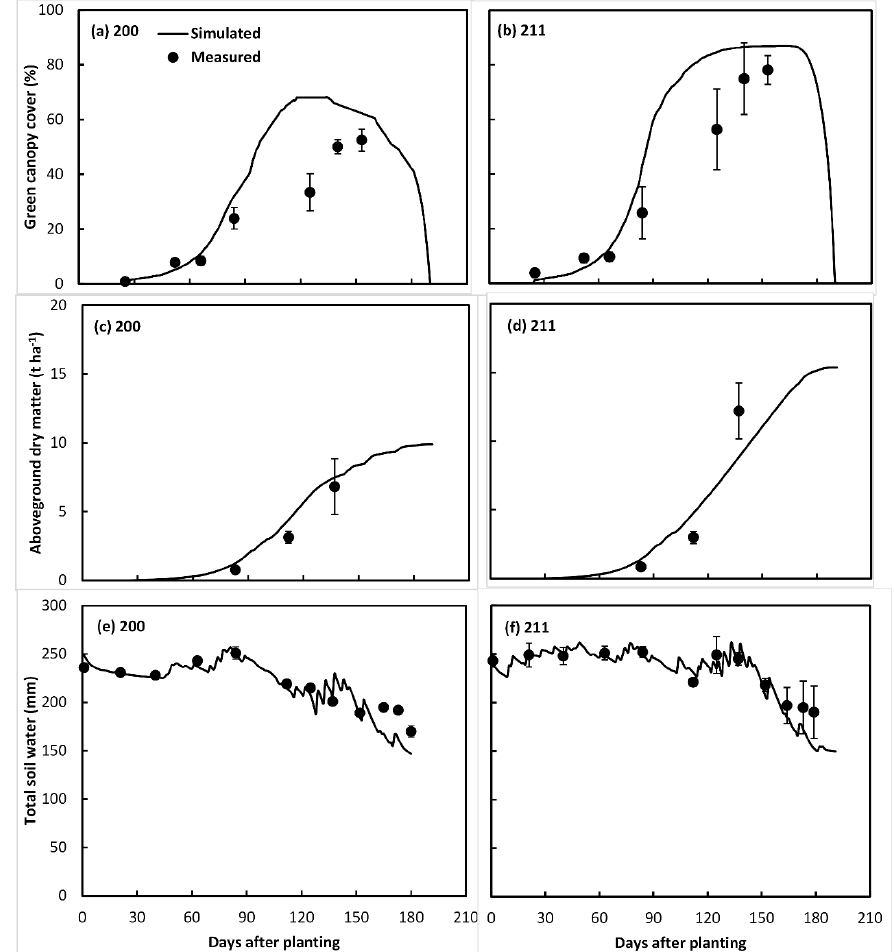
Figure 12. Measured and simulated green canopy cover (CC), above-ground dry matter (AGDM) and total soil water (TSW) for a late sown un-irrigated (200) and irrigated (211) faba bean. ( a ) Measured and simulated CC for 200; ( b ) measured and simulated CC for 211; ( c ) measured and simulated AGDM for 200; ( d ) measured and simulated AGDM for 211; ( e ) measured and simulated TSW for 200; ( f ) measured and simulated TSW for 211.